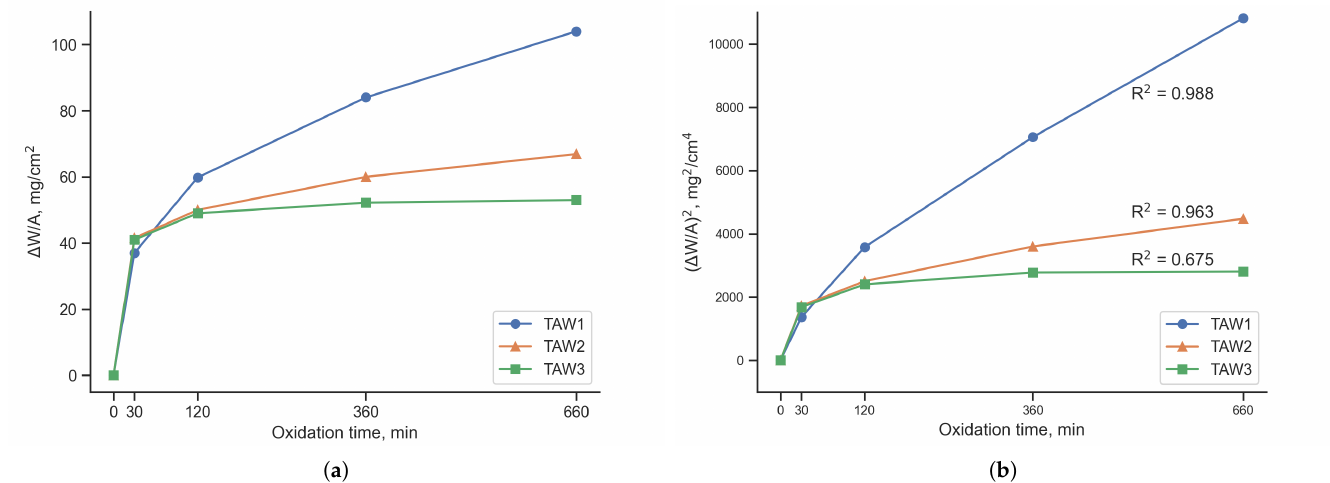
Figure 7. Weight gain per unit surface area ( ∆ W/A) ( a ) and their squares ( b ) as a function of oxidation time for all samples after isothermal oxidation testing at 900 ◦